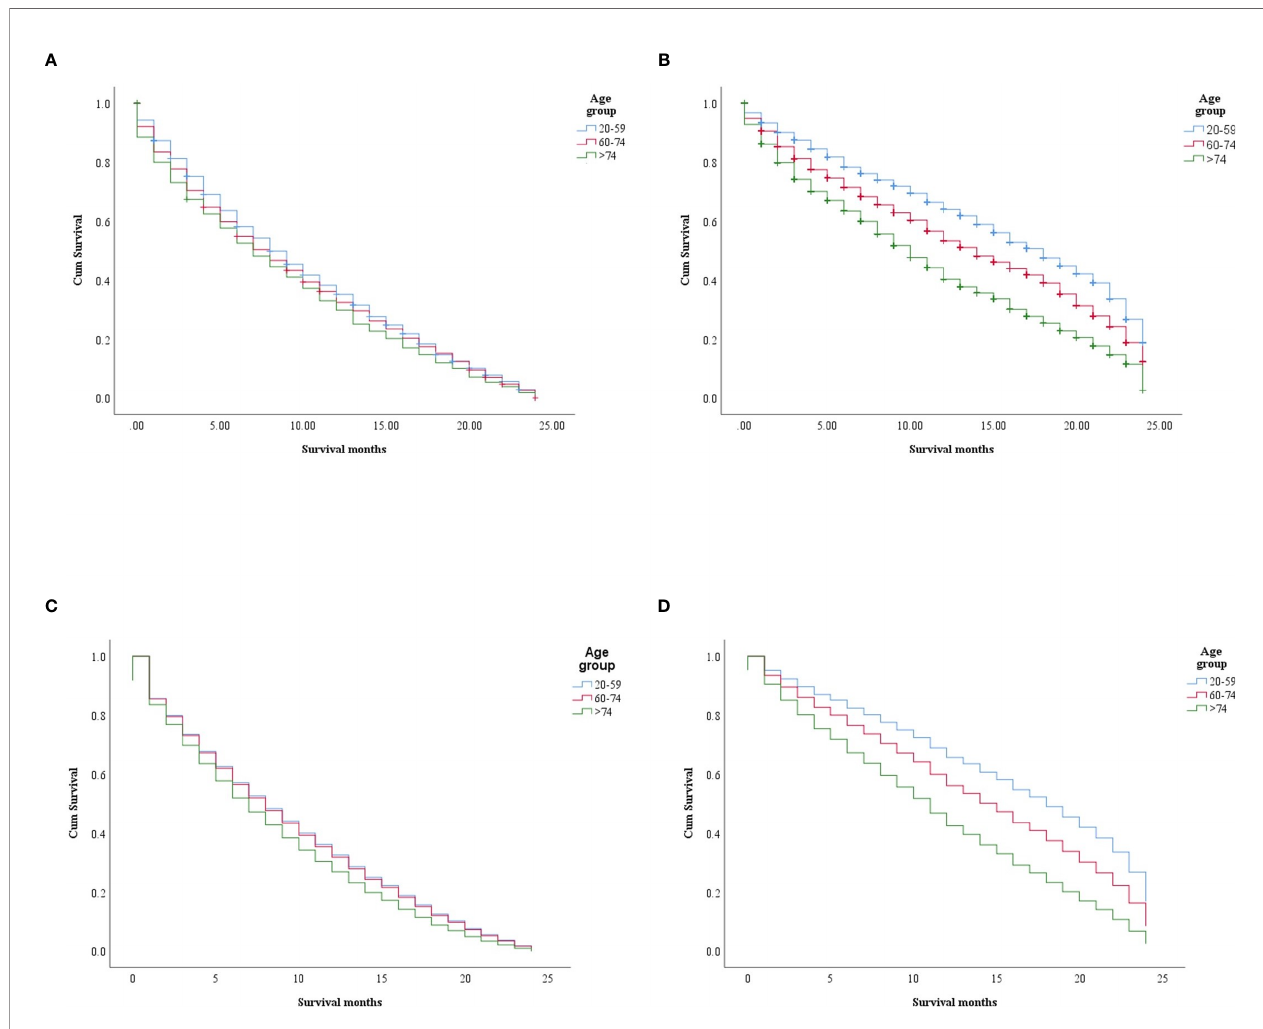
FIGURE 2 | Survival differences in the age groups within each era (non-ICI and ICI). (A, B) Kaplan – Meier (KM) survival difference in the non-ICI and the ICI era ( p = 0.0004 and p < 0.0001, respectively). (C, D) Multivariate Cox models for the age groups in the non-ICI era (20 – 59 years: p = 0.0001; 60 – 74 years: HR = 1.01, CI = 0.94 – 1.09, p = 0.614; >74 years : HR = 1.16, CI = 1.07 – 1.26, p = 0.0001) (C) and the ICI era (20 – 59 years: p < 0.0001; 60 – 74 years: HR = 1.37, CI = 1.261.50, p < 0.0001; >74 years: HR = 2.04, CI = 1.85 – 2.24, p < 0.0001) (D) . ICI , immune checkpoint